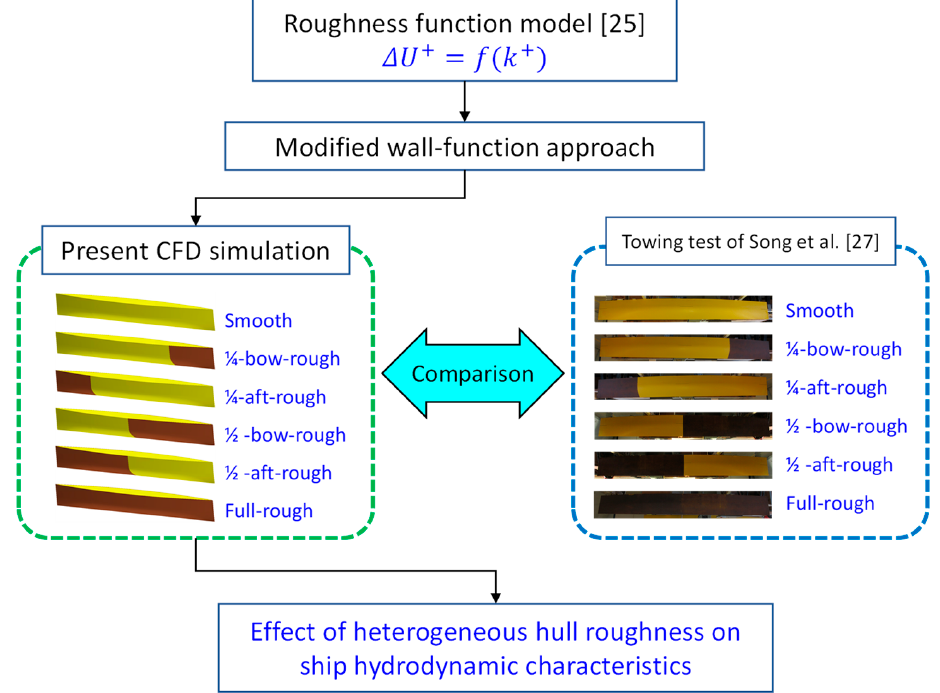
Figure 1. Schematic illustration of the current methodology.